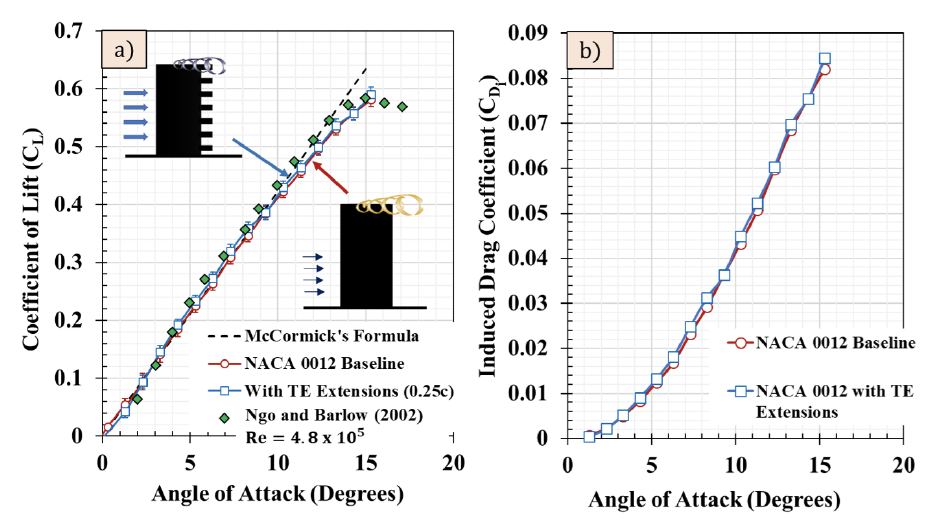
Figure 10. ( a ) Variation of Coefficient of Lift with angle of attack for the baseline wing and the wing with TE extensions. The lift curve slope shows similar variation with negligible differences between the two cases; ( b ) Variation of the coefficient of induced drag for both